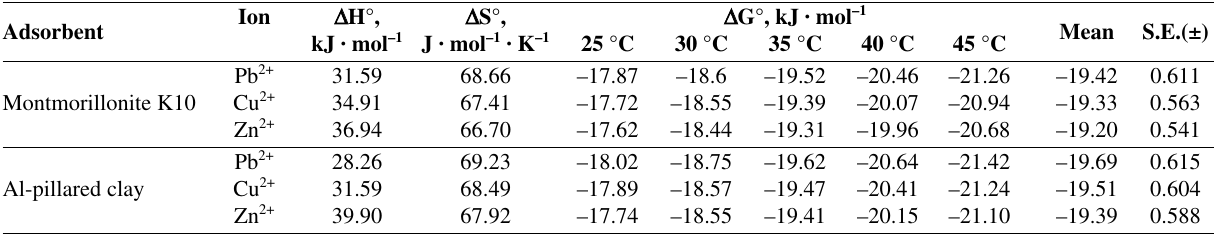
Table 2. Thermodynamic parameters for the adsorption of Pb 2+ , Cu 2+ and Zn 2+ onto montmorillonite-K10 and Al-pillared clay.